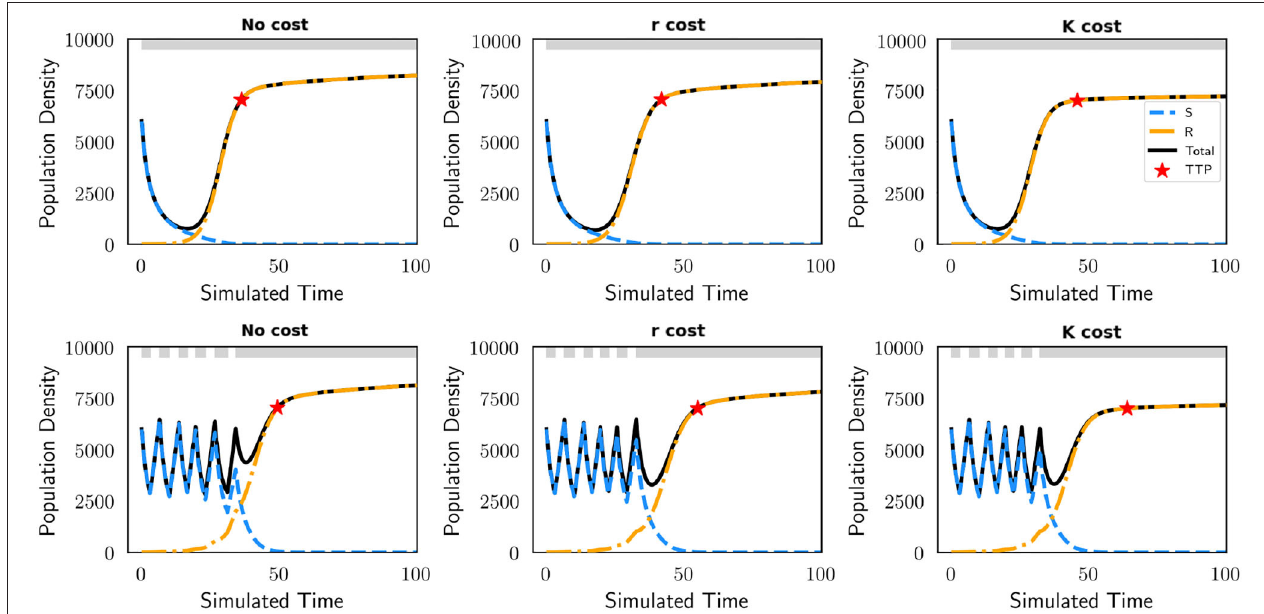
FIGURE 3 | Changes in the frequency of sensitive (blue) and resistant (yellow) subpopulations in the polymorphic context during MTD (top) and AT (bottom) . At the top of each plot, drug administration is shown in gray. These dynamics are shown for three different models of costs of resistance: no cost, cost applied to the growth rate ( r cost), and cost applied to the carrying capacity ( K cost). AT delays TTP (red star) by maintaining a tumor composition of mostly sensitive cells for a longer time than MTD. The parameters used in this figure are: m = 1, K max = 10,000, r max = 0.45, k = 2, b = 10, d = 0.01, g = 0.1, σ = 0.1.